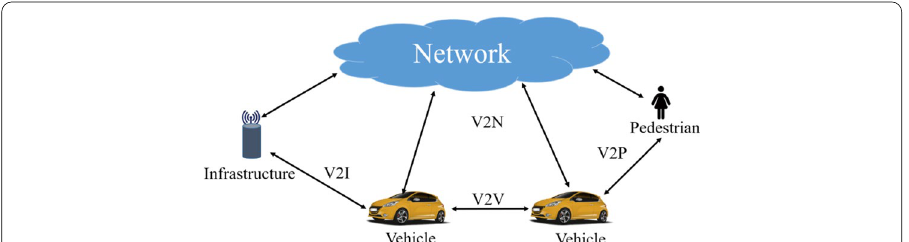
Fig. 1 Various V2X scenarios in IoT systems. The V2V network is composed of the vehicles connected to each other. The vehicles also communicate with the infrastructure and pedestrian to form V2I and V2P. The